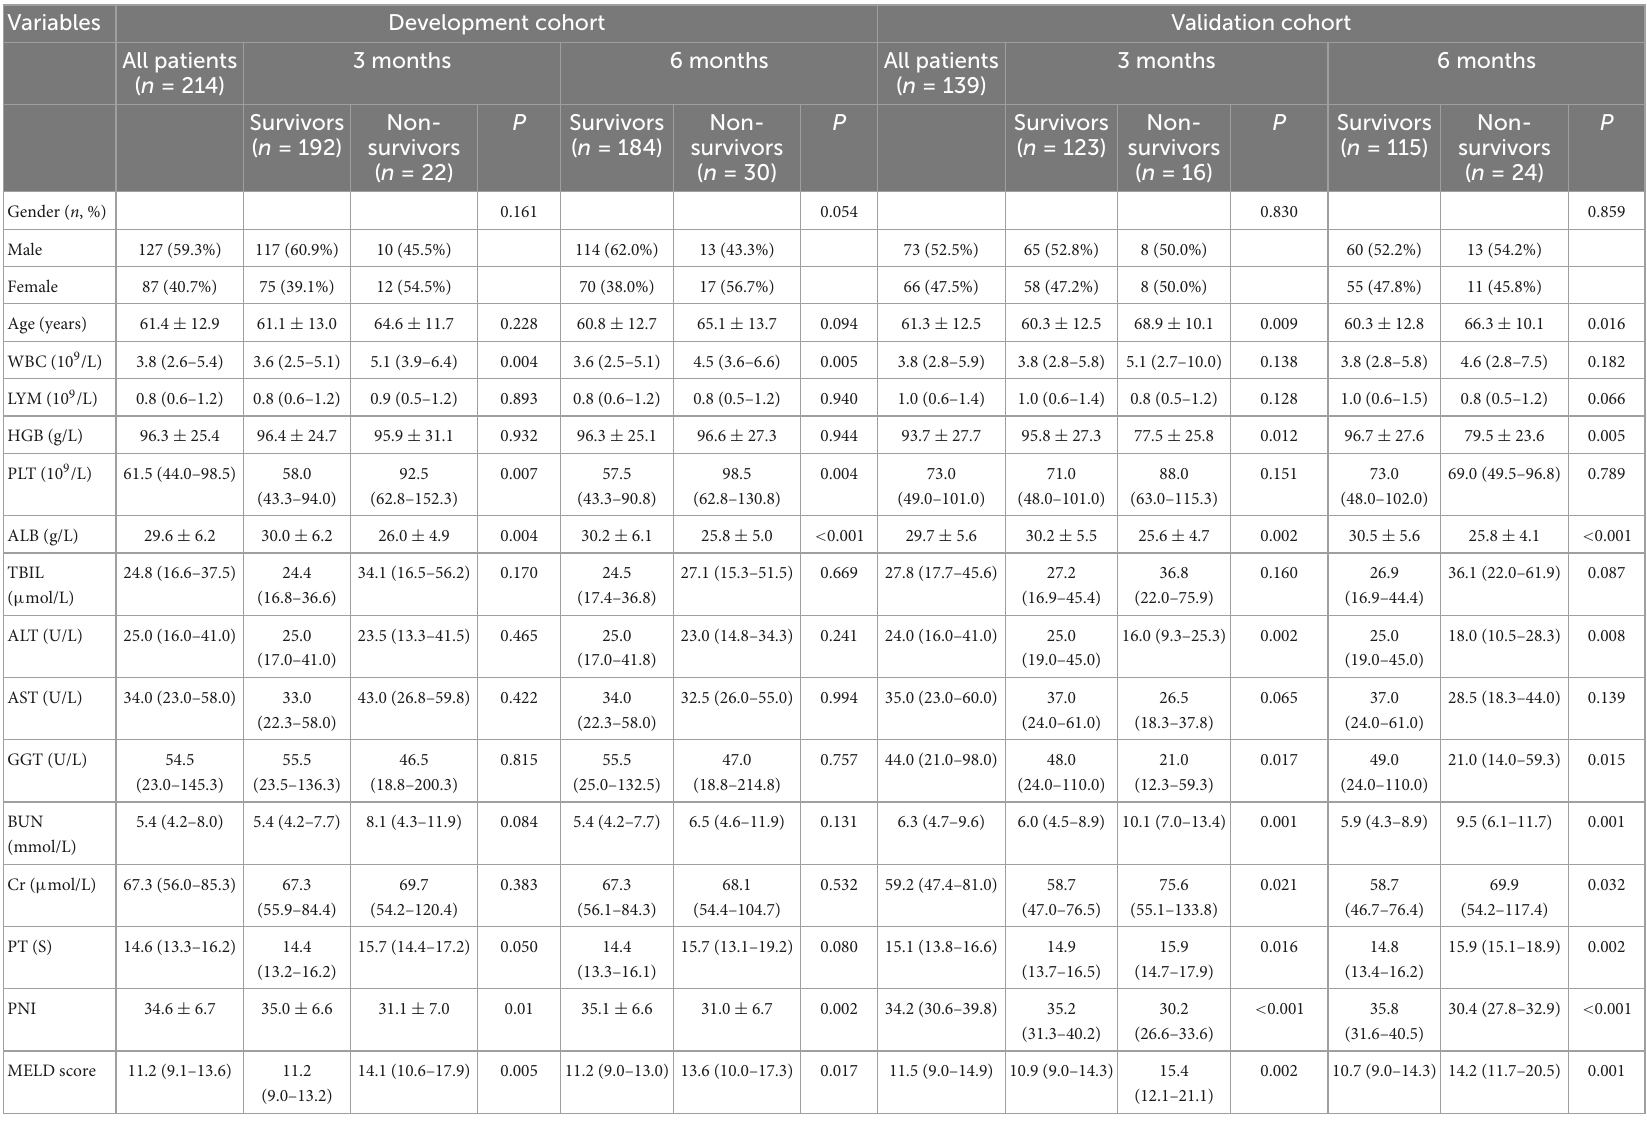
TABLE 1 Clinical and laboratory characteristics of the decompensated liver cirrhosis patients in the development and validation cohort at the 3-month, and 6-month